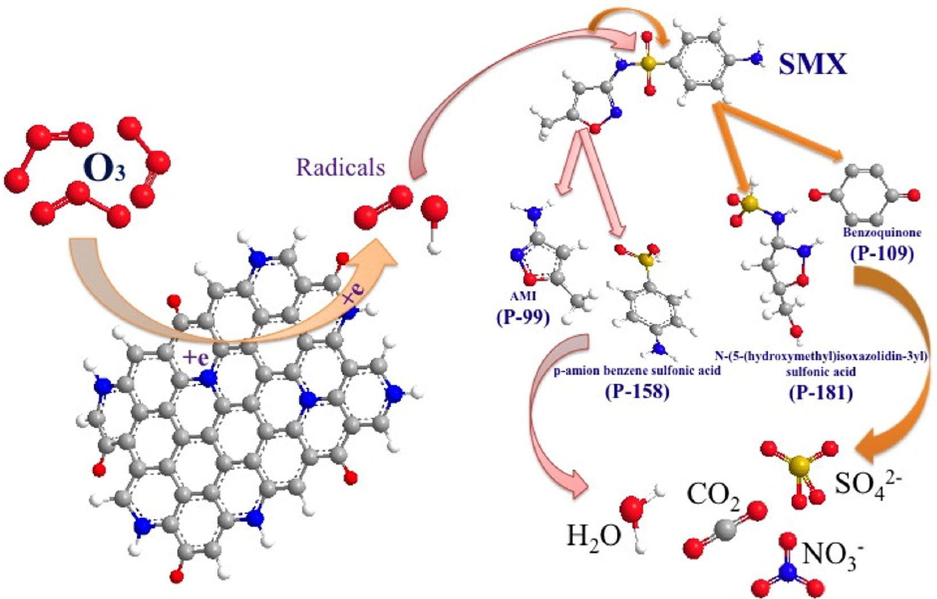
Figure 6. Degradation mechanism of catalytic ozonation for sulfamethoxazole using heteroatoms doped graphene. Reproduced with permission from Ref. [84].